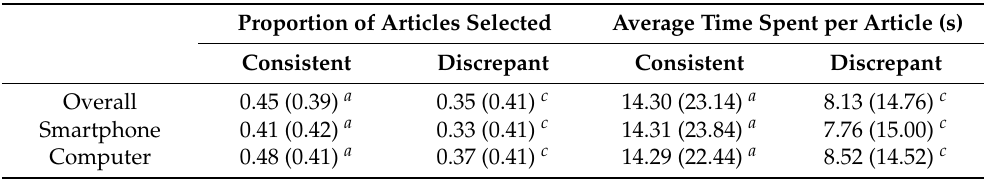
Table 4. Confirmation Bias by Browsing Device Condition (Study